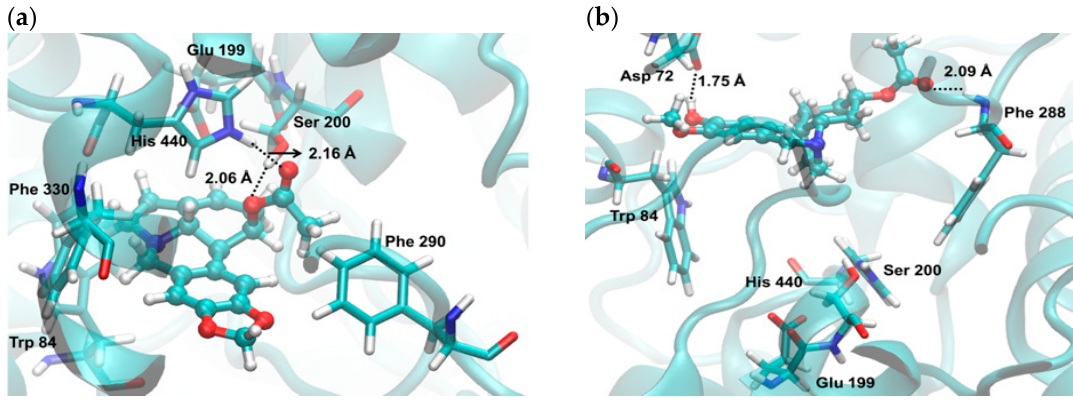
Figure 5. Graphical representations of the binding of ( a ) 1- O -acetylcaranine ( 2 ) and ( b ) cantabricine ( 11 ) in the gorge of the active site of TcAChE. ( 11 ) in the gorge of the active site of TcAChE.